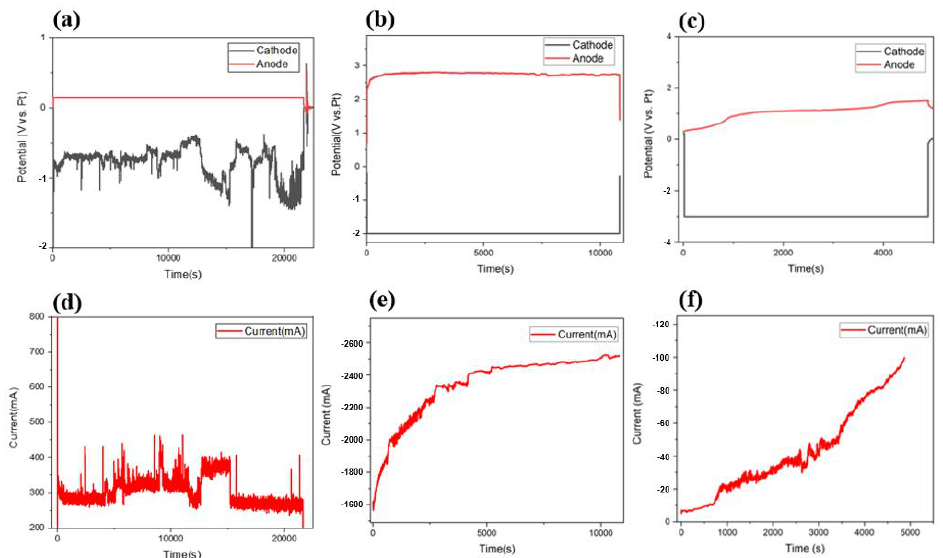
Figure 3. CA analysis results for formed electrode potential and currents during the deoxidation process under different applied voltage conditions. − 0.2 V ( a ) and ( d ); − 2 V ( b ) and ( e ); − 3 V ( c ) and ( f ).